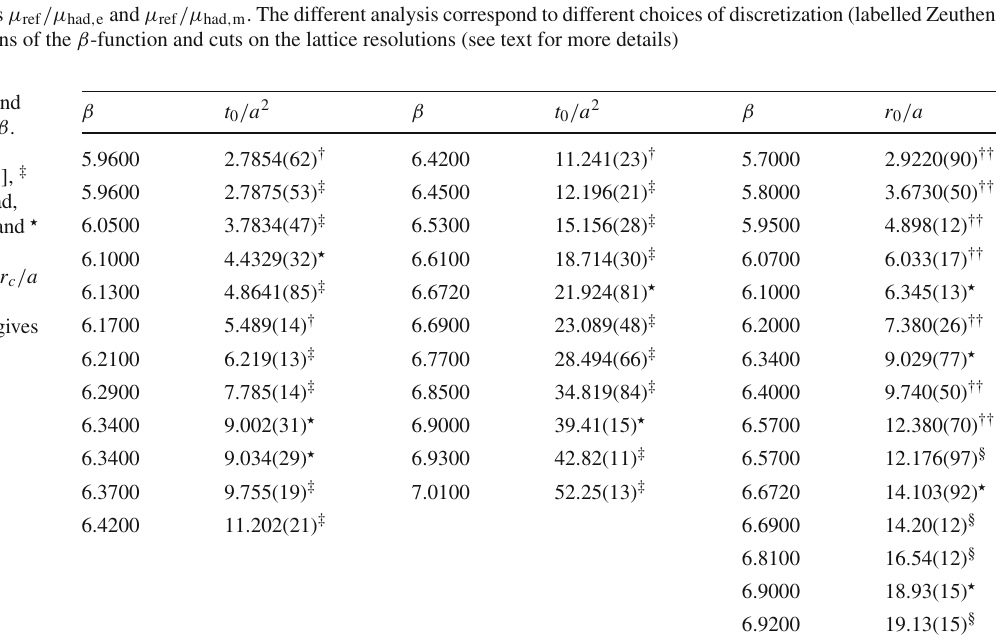
Table5 Valuesofthebarecoupling β had ( L / a ) fordifferentlatticesizesanddiscretizationswhichcorrespondtoafixedcoupling ¯ g 2